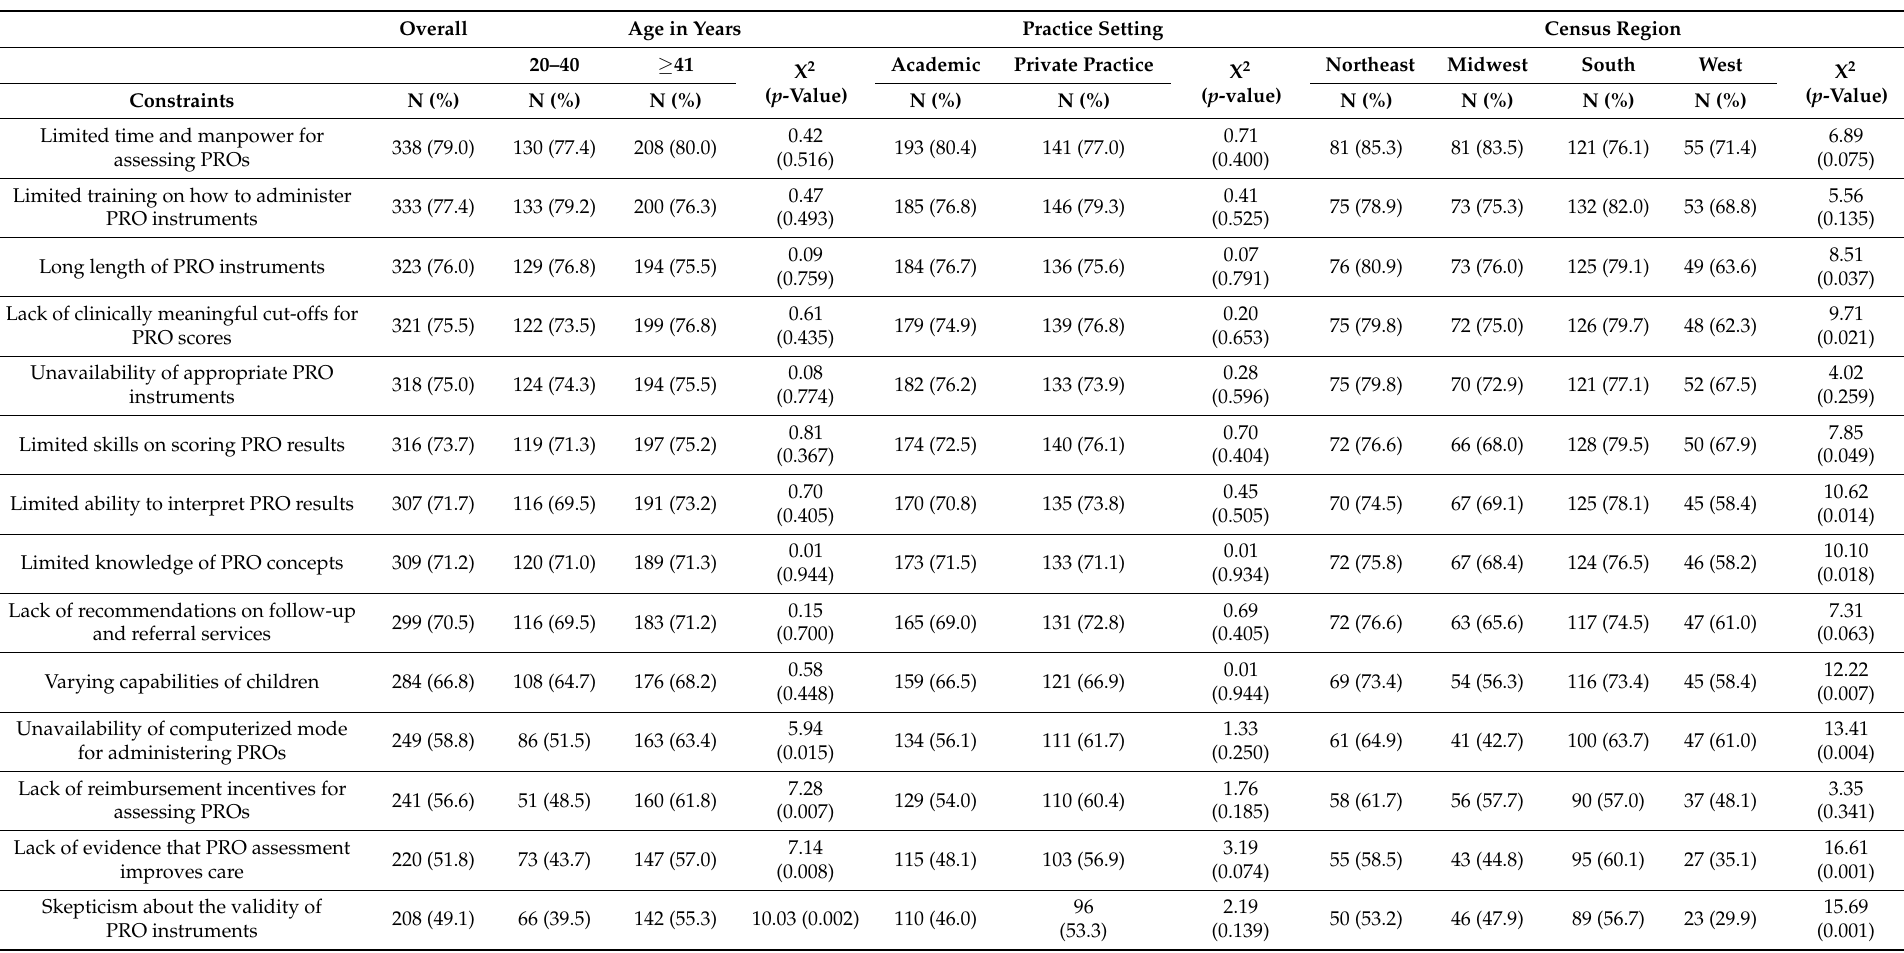
Table 3. Bivariate Analyses for Pediatricians’ Age, Practice Setting, and Census Region Associated with Human and Logistic Barriers to PRO Assessment † . Overall Age in Years Practice Setting Census Region 20–40 ≥ 41 X 2 ( p -Value)